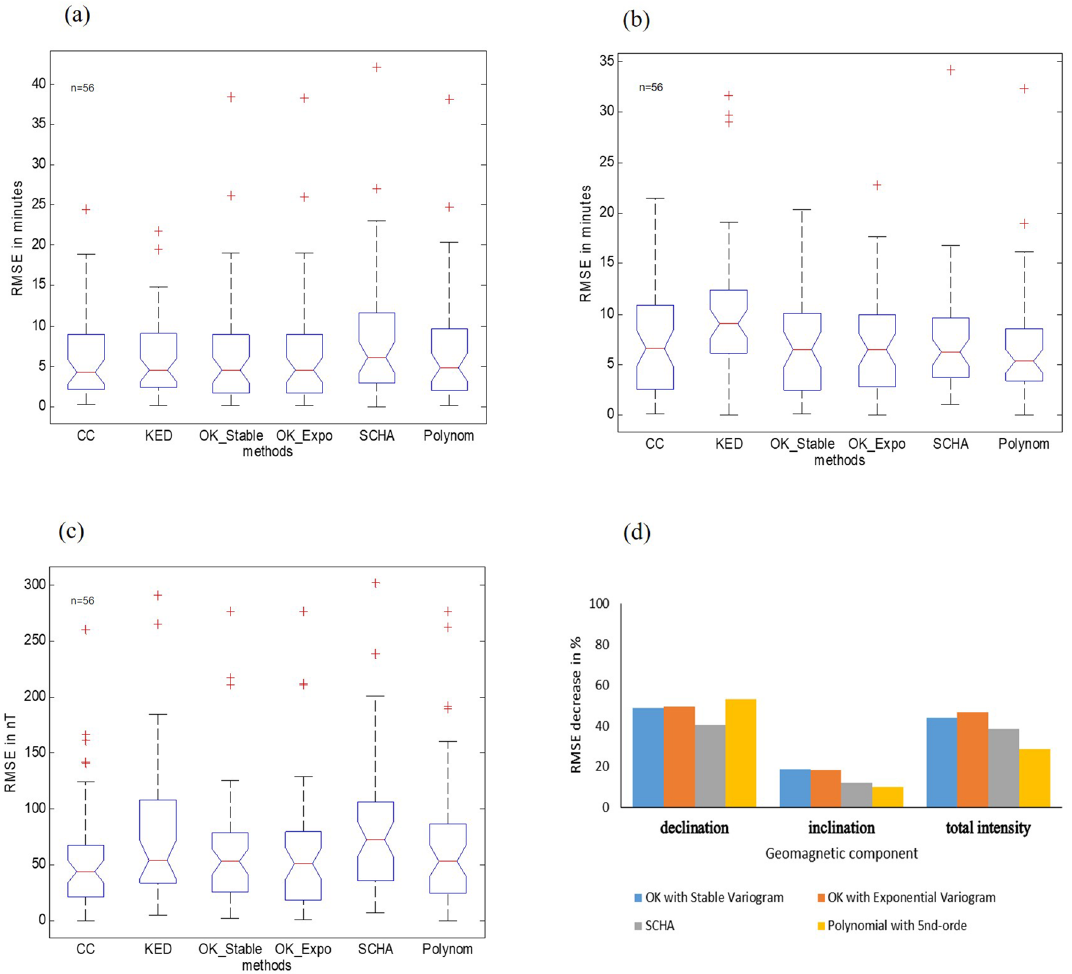
Figure 3. Boxplot of root mean square error (RMSE) ( n = 56 data) between data estimation and validation from the CC, KED, OK methods with stable variogram, OK with exponential variogram, SCHA, and polynomial methods data for epoch 1985– 2015 for each geomagnetic component. ( a ) Declination Component (minutes); ( b ) Inclination Component (minutes); ( c ) Total Intensity (nT); ( d ) RMSE decreased below normalized value due to the addition of 28% more sample